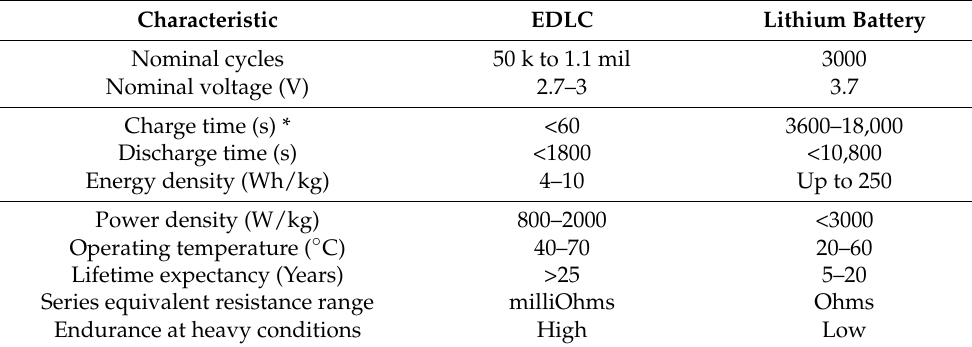
Table 7. Comparison of characteristics for battery and ultracapacitors